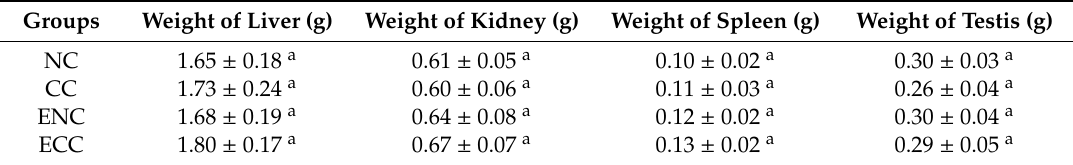
Table 6. Organ weights of ICR mice.